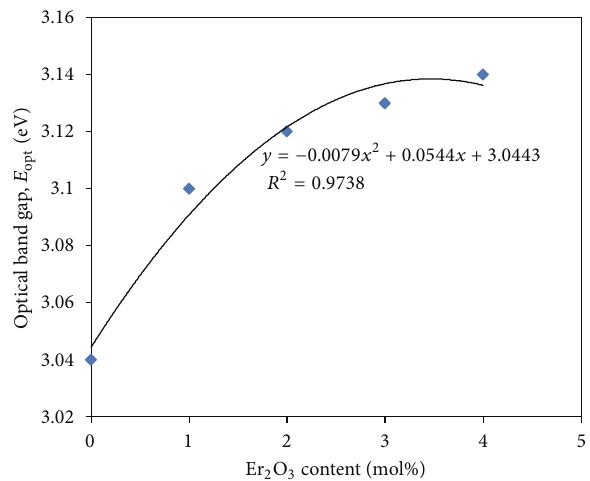
variation in various Er 2 O 3 opt